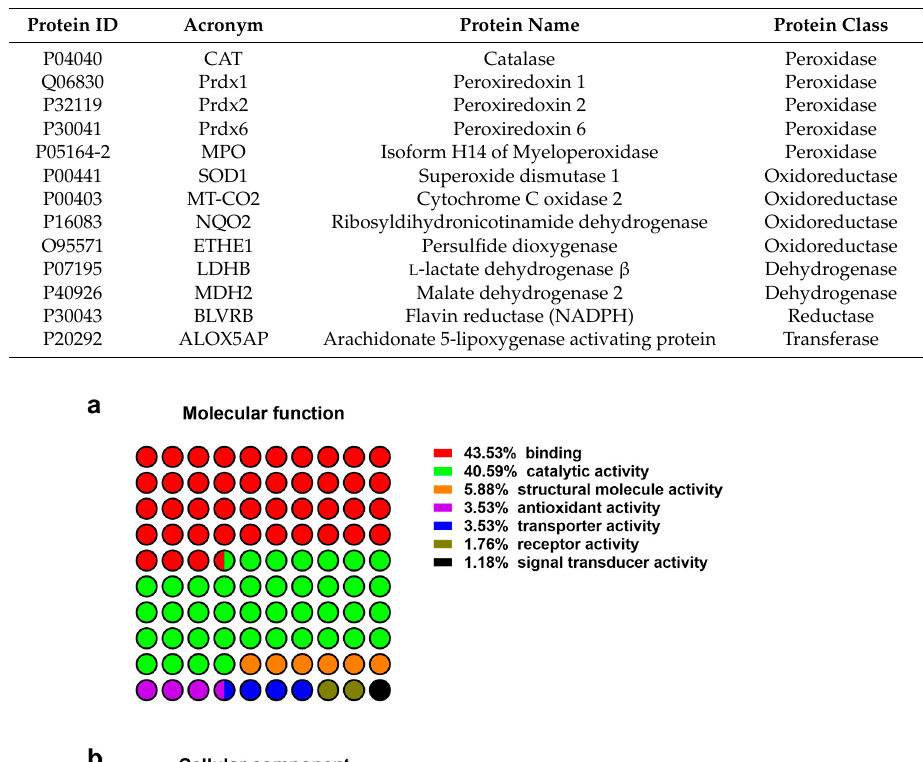
Table 2. Oxidoreductases in wound fluids.